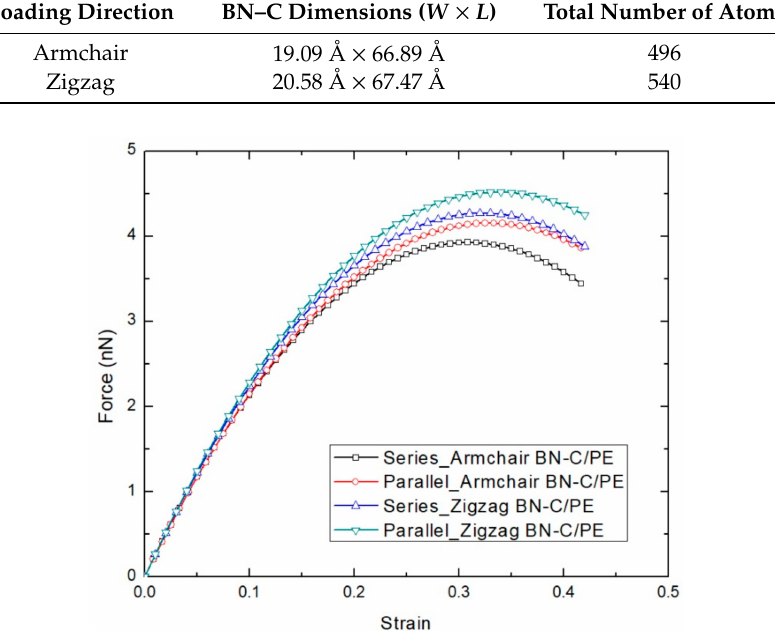
Figure 6. Force–strain plot of BN–C / PE nanocomposite variants at 300 K.